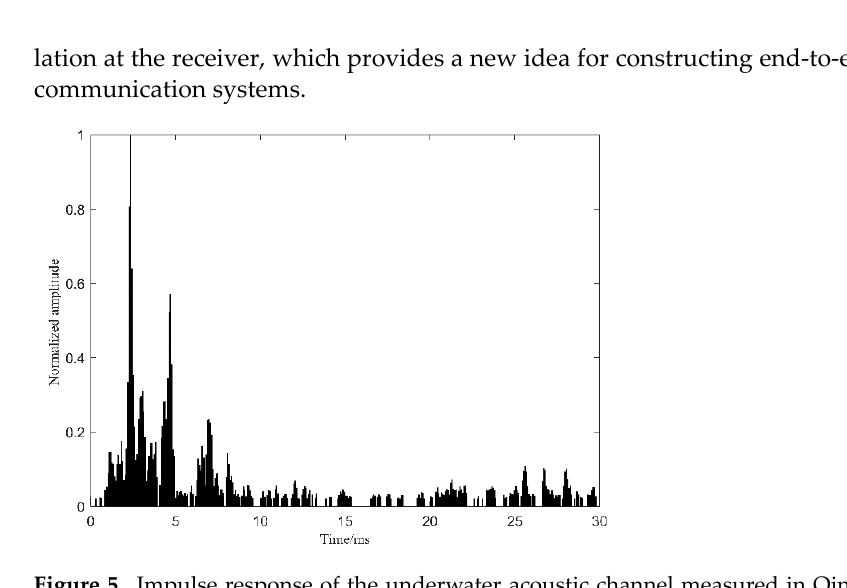
Table 3. Conv1D autoencoder hyperparameter settings.